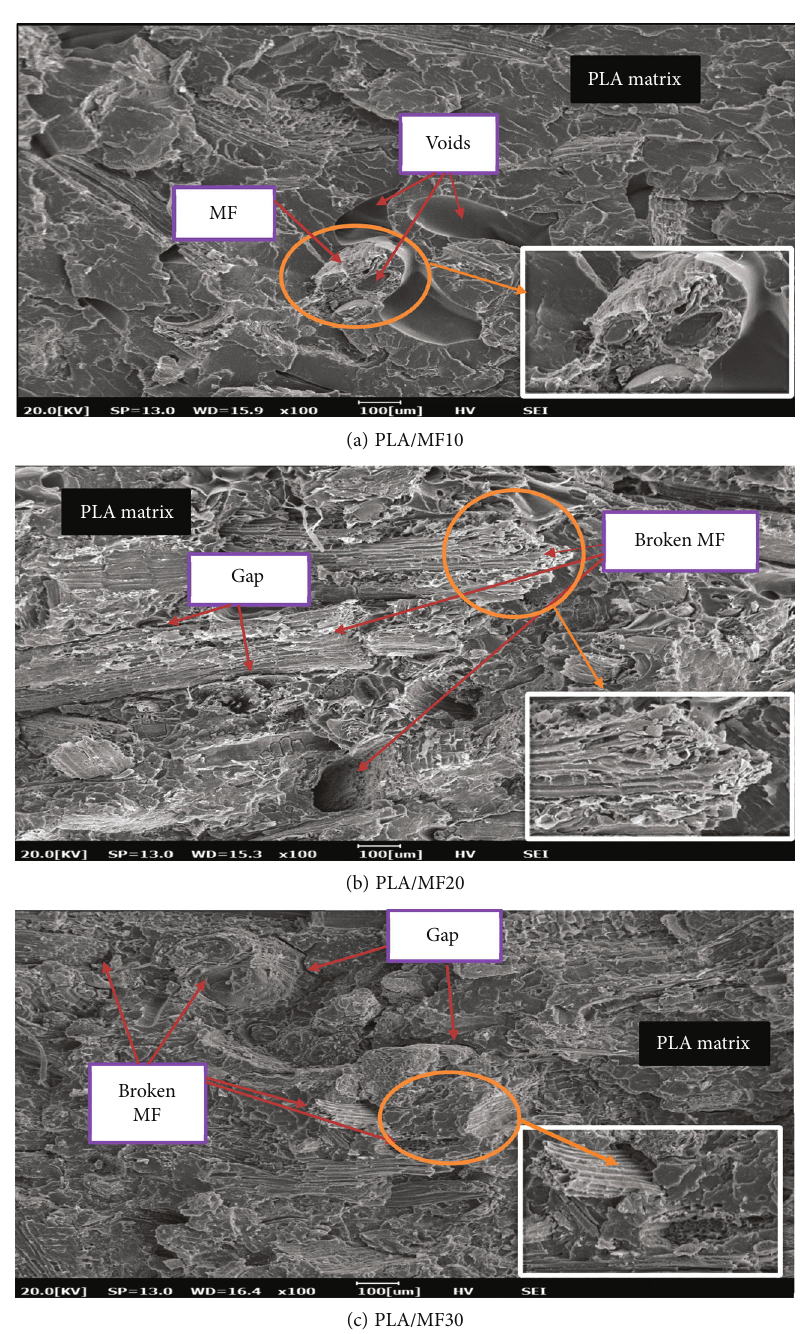
Figure 7: SEM micrograph of PLA/MF tensile fractured surfaces of di ff erent loading (a) PLA/MF10 wt. %, (b) PLA/MF20wt. %, and (c) PLA/MF30wt. % with 100 magni fi